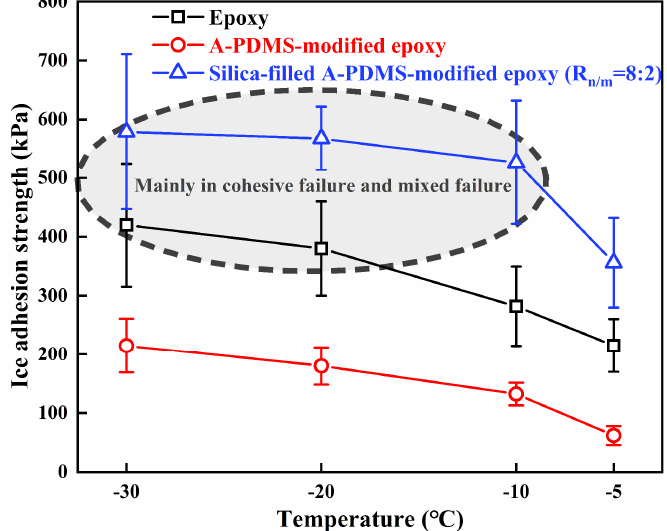
Figure 11. Ice adhesion strength of epoxy, A-PDMS-modified epoxy and nano/microsilica-filled A-PDMS-modified epoxy coatings ( R n/m = 8:2) at different temperatures. The error bar is one standard deviation.